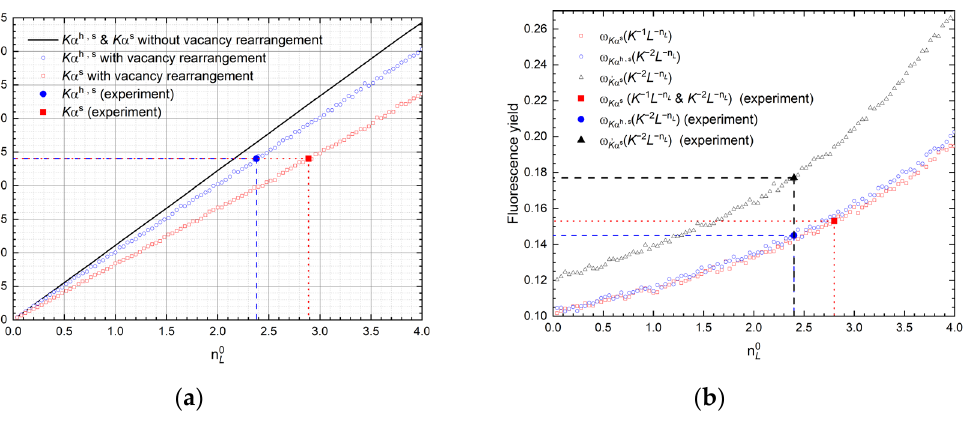
ver- versus L 𝐿𝐿𝑥𝑥 𝑛𝑛